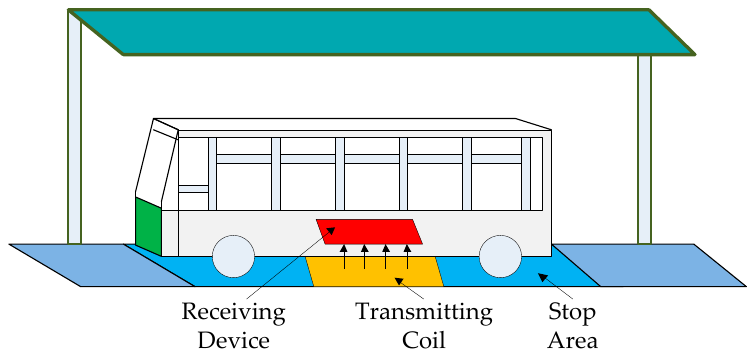
Figure 3. The schematic diagram of the opportunistic stationary wireless-charging scenario for an electric bus.